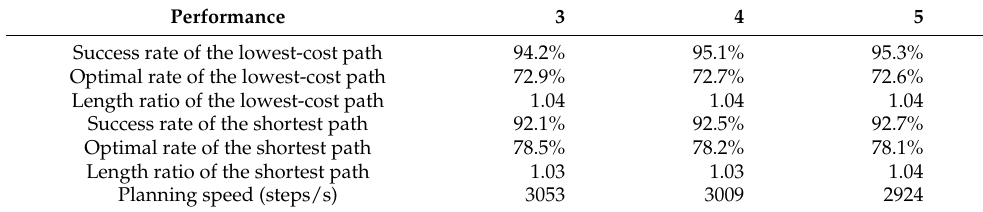
Table 5. Performance of different limits of rollbacks.